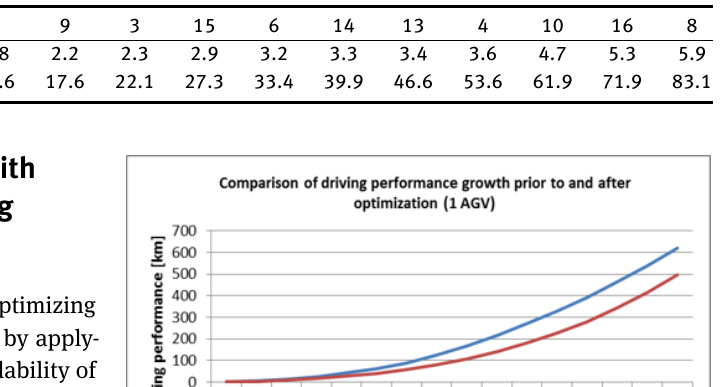
distance optimization by implementing Greedy algorithm when using single AGV. Obviously, as a result of optimiza- tion, driving performance increases with the number of operated centers slower than prior to optimization (left graph), as well as overall driving performance is lower compared to the original state (right graph). At the top of the x -axis of the left graph, the descrip- tion of customers’ random delivery sequence prior to the distance optimization of operation is indicated, and at the bottom of the x -axis, the new delivery sequence after the optimization when applying Greedy algorithm is